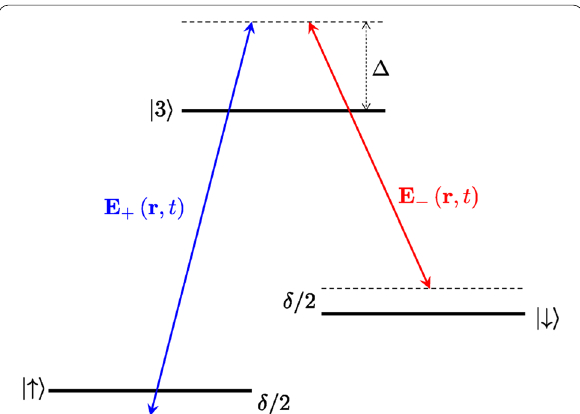
Fig. 1 Scheme of the SOAM coupling. Two hyperfine states of atoms (denoted by and ) are coupled to an excited state |↑� |↓� far‑detuned copropagating Laguerre‑Gaussian beams E and (cid:31) are the two‑photon and single‑photon detunings